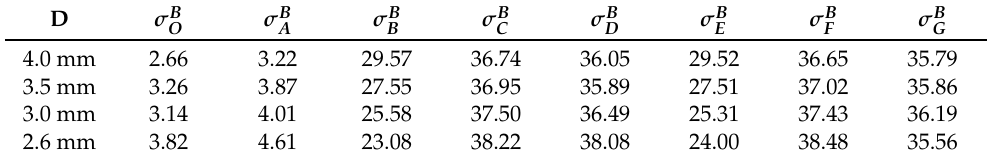
Table 4. Stress at different positions of triaxial geogrid after transverse stretching. (MPa).